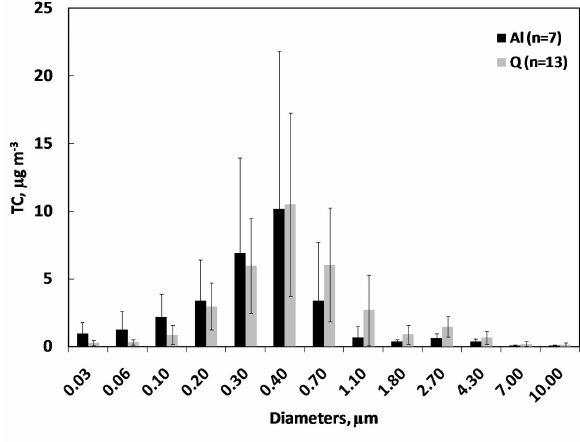
Fig. 7. Size-resolved averaged TC mass concentration when using aluminum substrates ( n = 7) and quartz fiber filters ( n = 13) for the DLPI